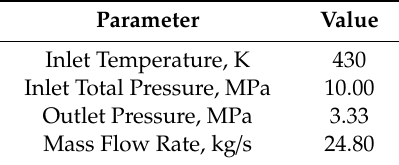
Table 3. The design conditions of the radial turbines for the case study.